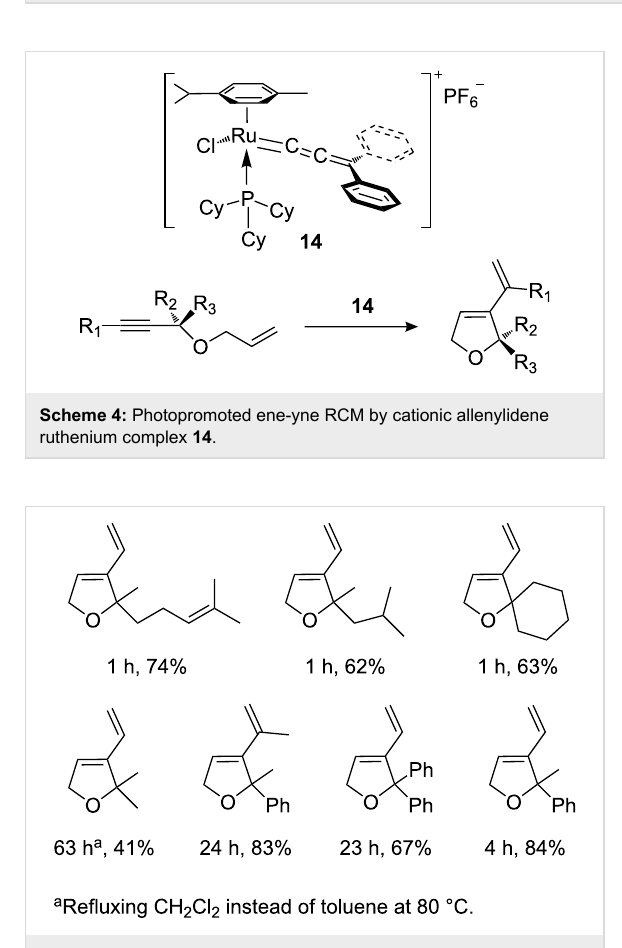
In line with the development of ruthenium benzylidene initi- ators [66,67], the phosphane ligand was replaced by an N -hete- rocyclic carbene (NHCs) in the photoactivated precatalysts. Accordingly, Noels et al. [68,69] synthesised a range of